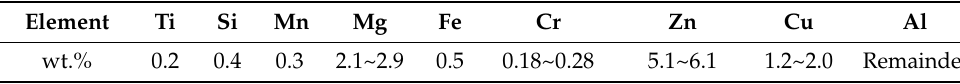
Table 2. Material properties of 7075-T651.